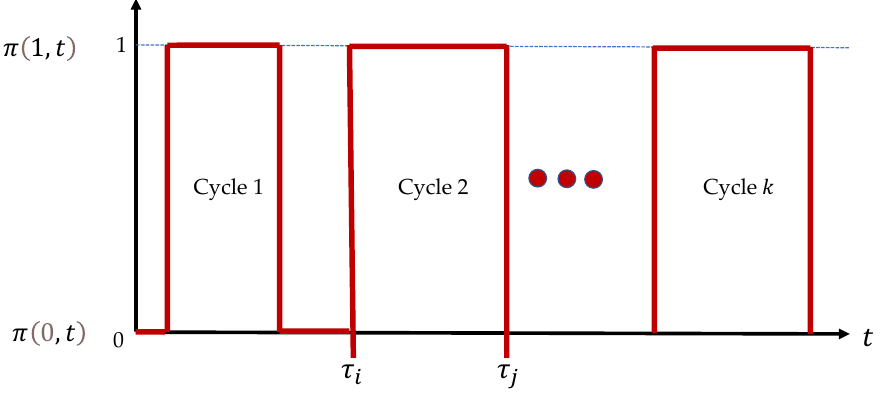
Figure 2. Alternative process cycles d